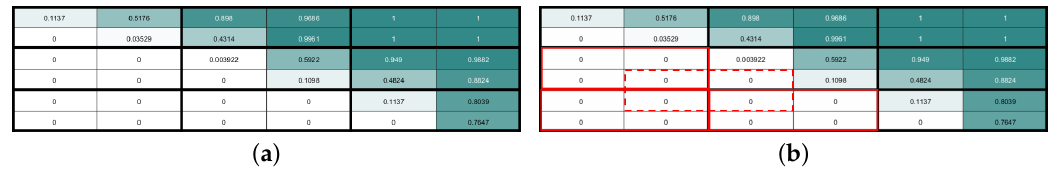
Figure 7. Finding the new position of the drone. ( a ) the heatmap after subdivision—set of new solutions after subdivision; ( b ) the dashed box is the best